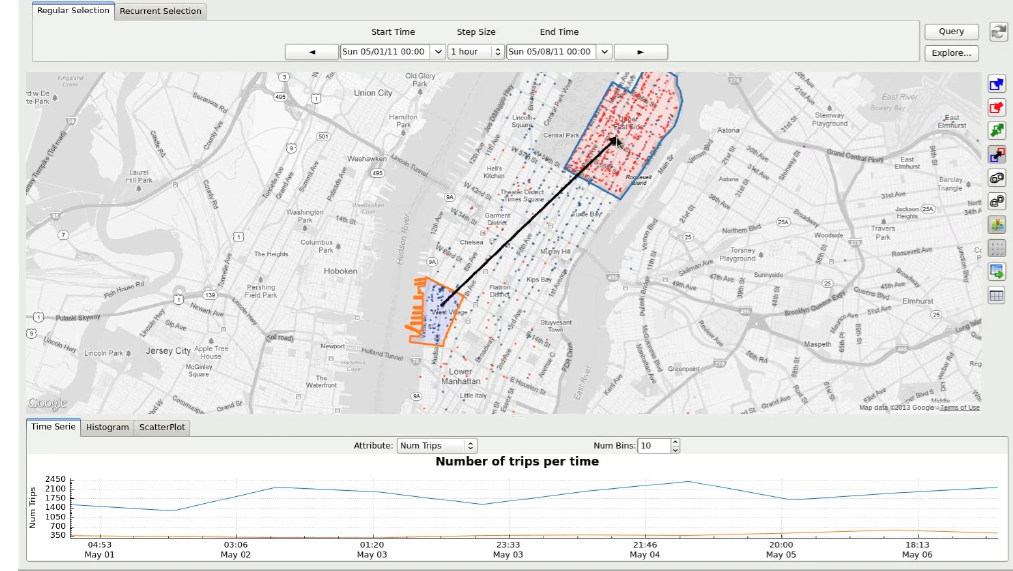
Figure 9. The TaxiVis system for exploring mobility patterns from taxi trips [43] (adapted from [45]).